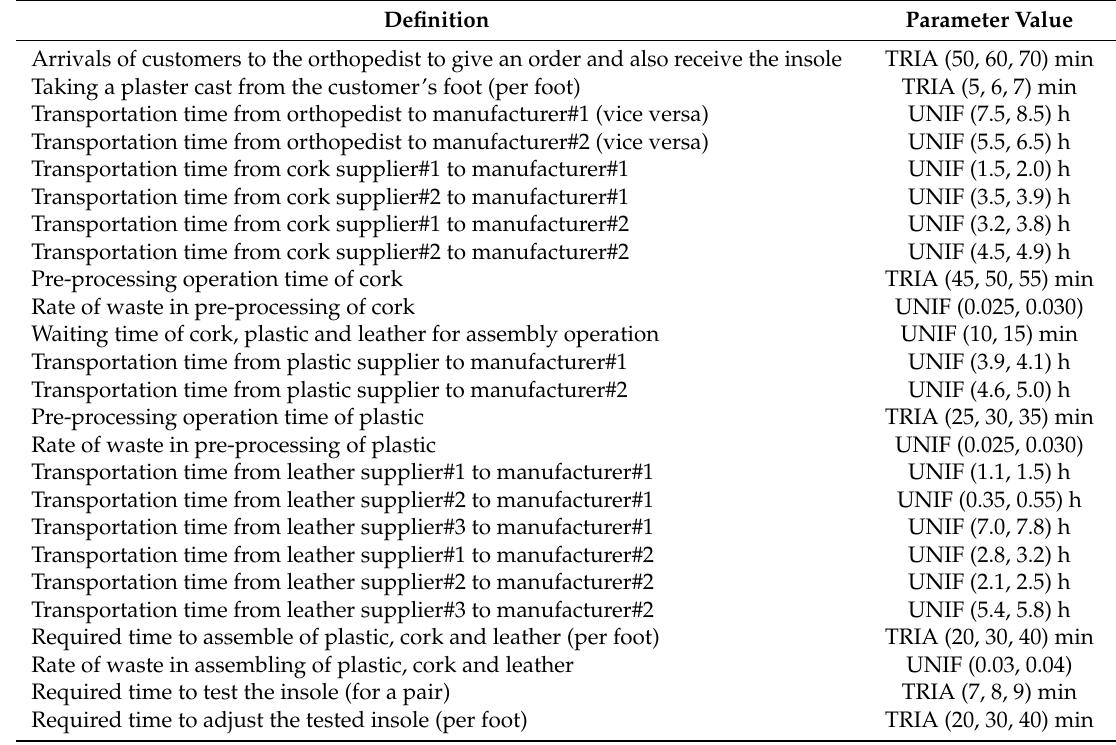
Table 1. Parameters used in TSCN simulation